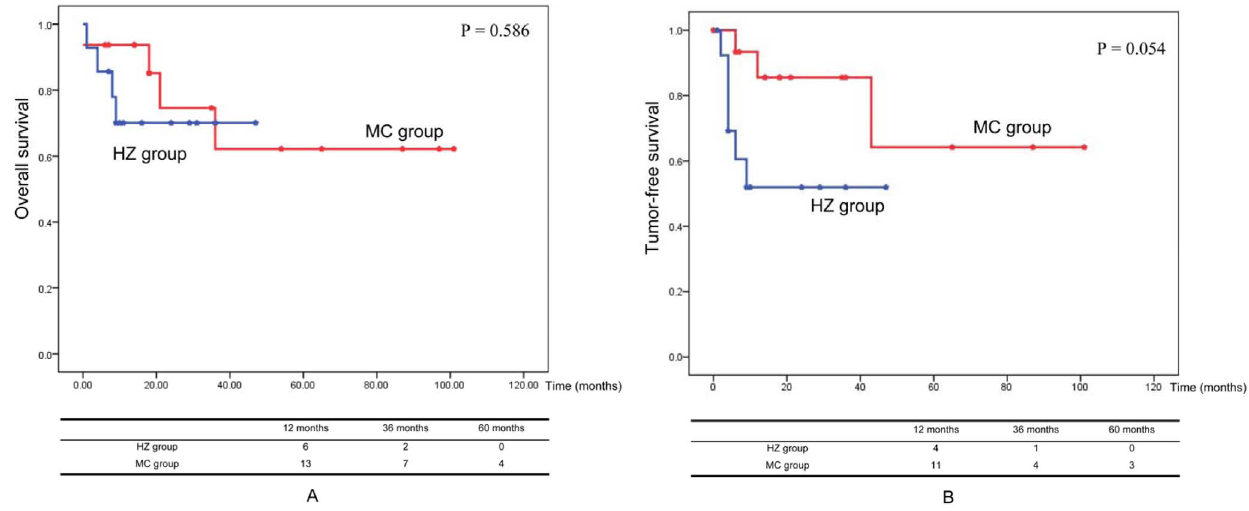
Figure 3. Among SLT recipients who fulfilled the Hangzhou criteria, the Milan criteria did not differentiate further. Recipients fulfilling the Milan criteria and therefore also the Hangzhou criteria (MC group), recipients fulfilling the Hangzhou criteria but exceeding the Milan criteria (HZ group). A) overall survival, B) tumor-free survival.